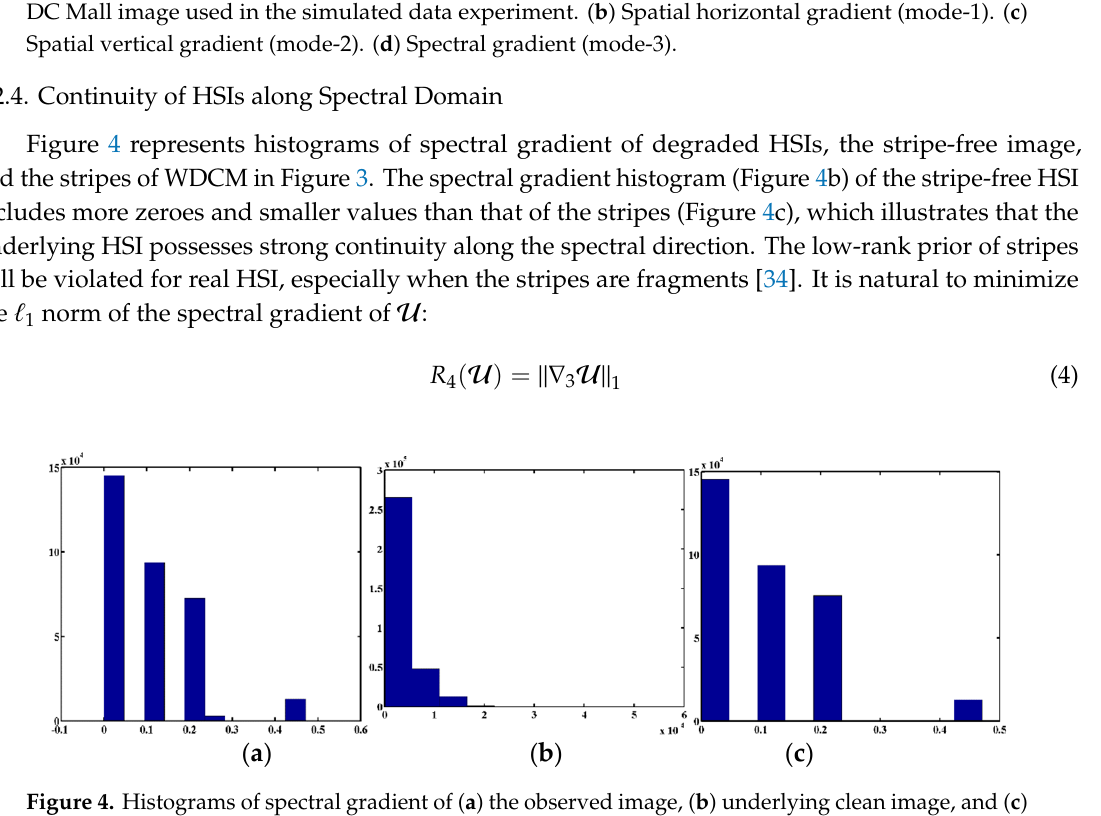
Figure 3. Directional characteristic of stripes in a hyperspectral image (HSI). ( a ) Original Washington DC Mall image used in the simulated data experiment. ( b ) Spatial horizontal gradient (mode-1). ( c ) Spatial vertical gradient (mode-2). ( d ) Spectral gradient (mode-3).